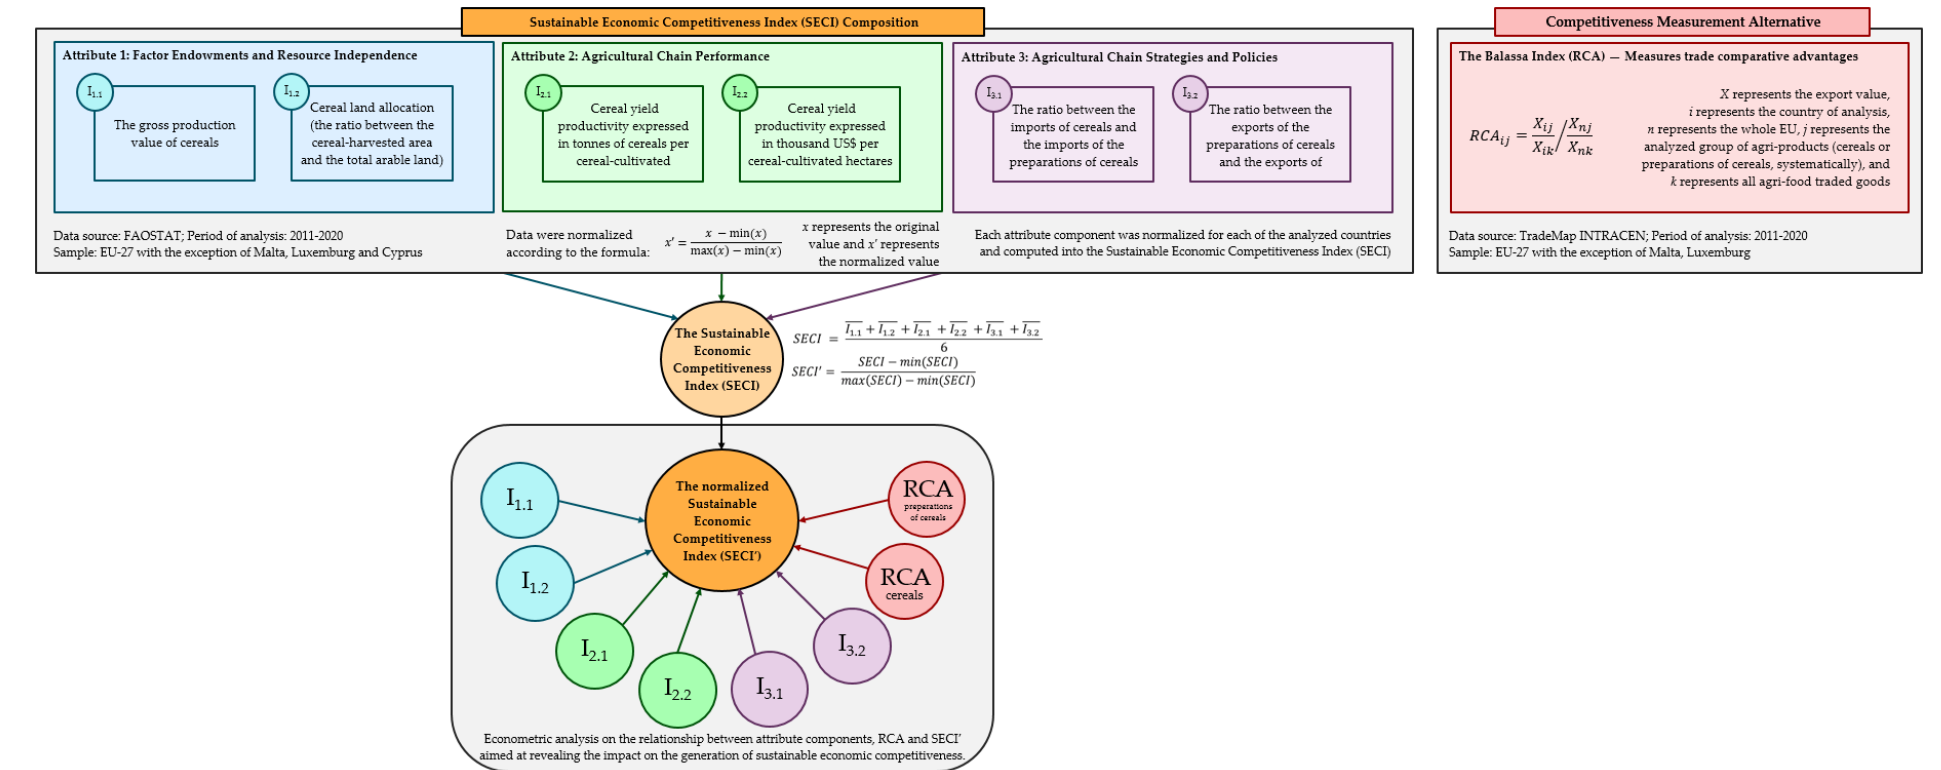
Figure 1. Research diagram flow.